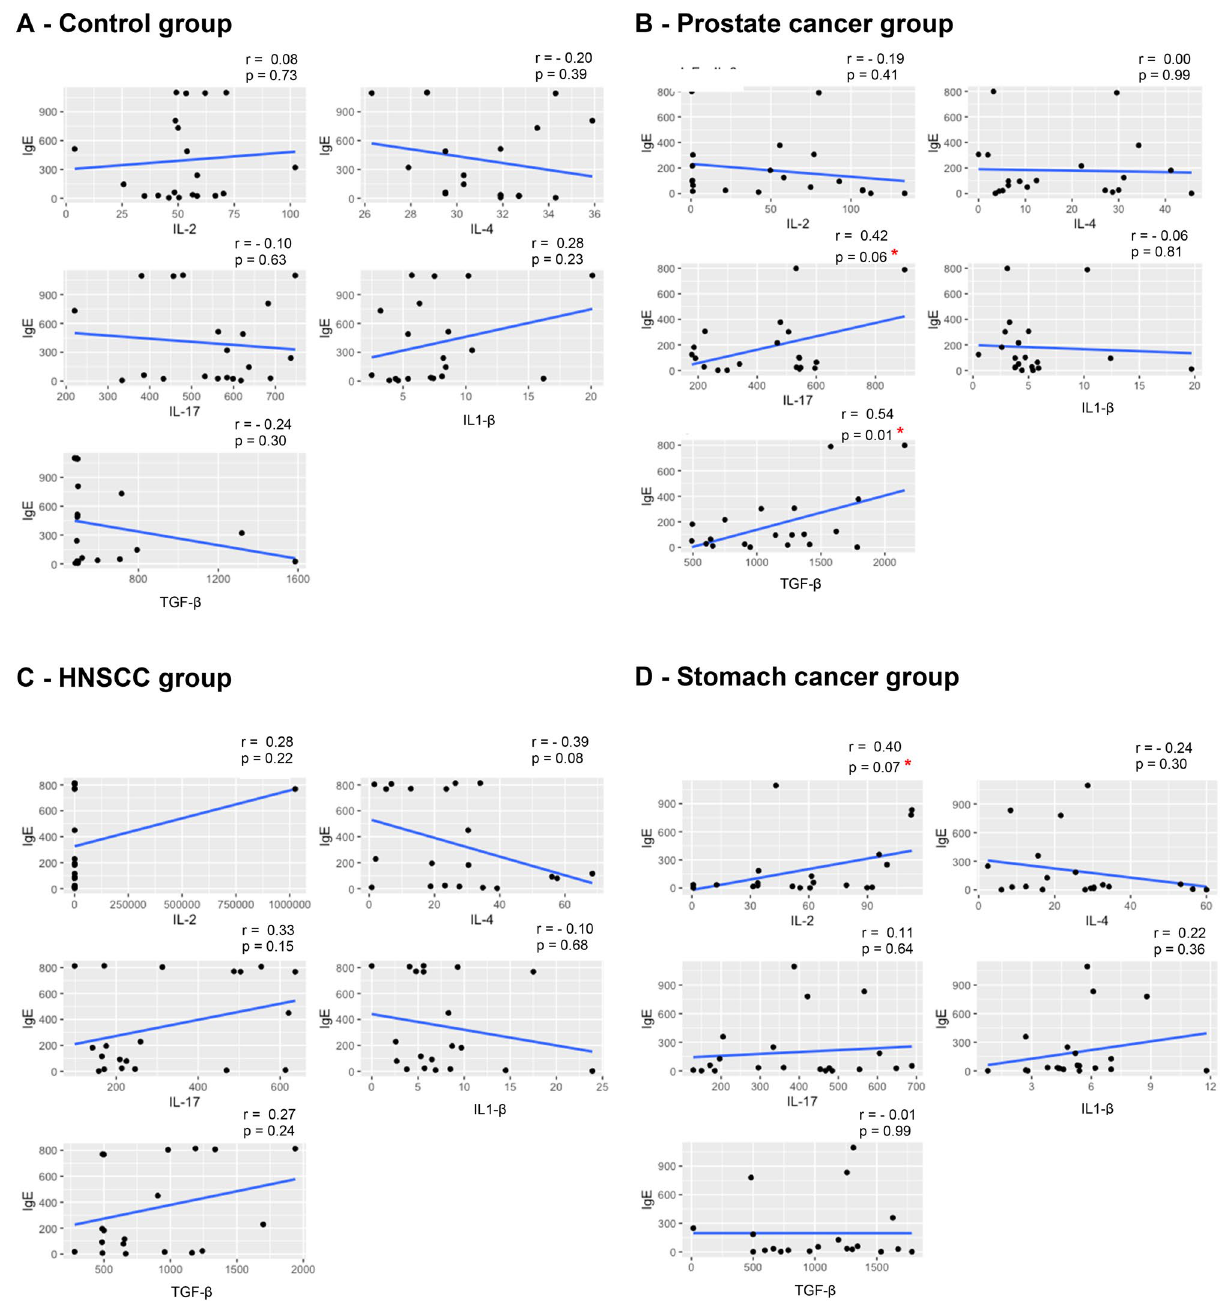
Figure 1. Dispersion diagrams and linear regression axes based on the correlation factors between cytokines (pg/ml) and IgE (UI/ml), stratified by patient group. Spearman Correlation Test. * Groups with a moderate correlation ( Devore JL 45 ) . Groups: Control (n = 20), Prostate cancer (n = 20), HNSCC (n = 20), Stomach cancer (n = 20). Abbreviations: IgE = immunoglobulin E, IL = interleukin, TGF = transforming growth factor, HNSCC = head and neck squamous cell